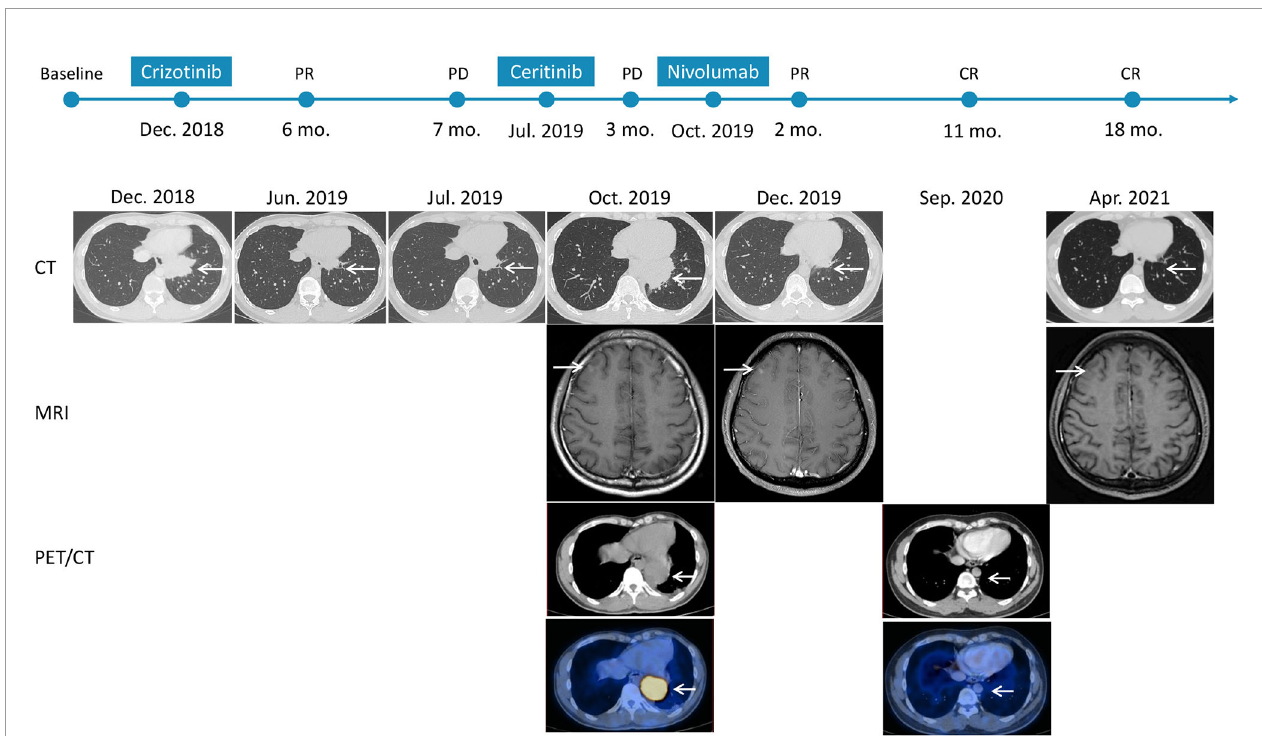
FIGURE 2 | Time course depicting treatment process and radiological evaluation from 2018 to 2021. The PFS of crizotinib and ceritinib were 7 months and 3 months, respectively. And the duration of nivolumab was 18 months at the time of this report, and the patient is at present still on treatment and is receiving the drug. PR, partial response; PD, progressive disease; CR, complete response; CT, computed tomography; MRI, magnetic resonance imaging; PET/CT, positron emission tomography/computed